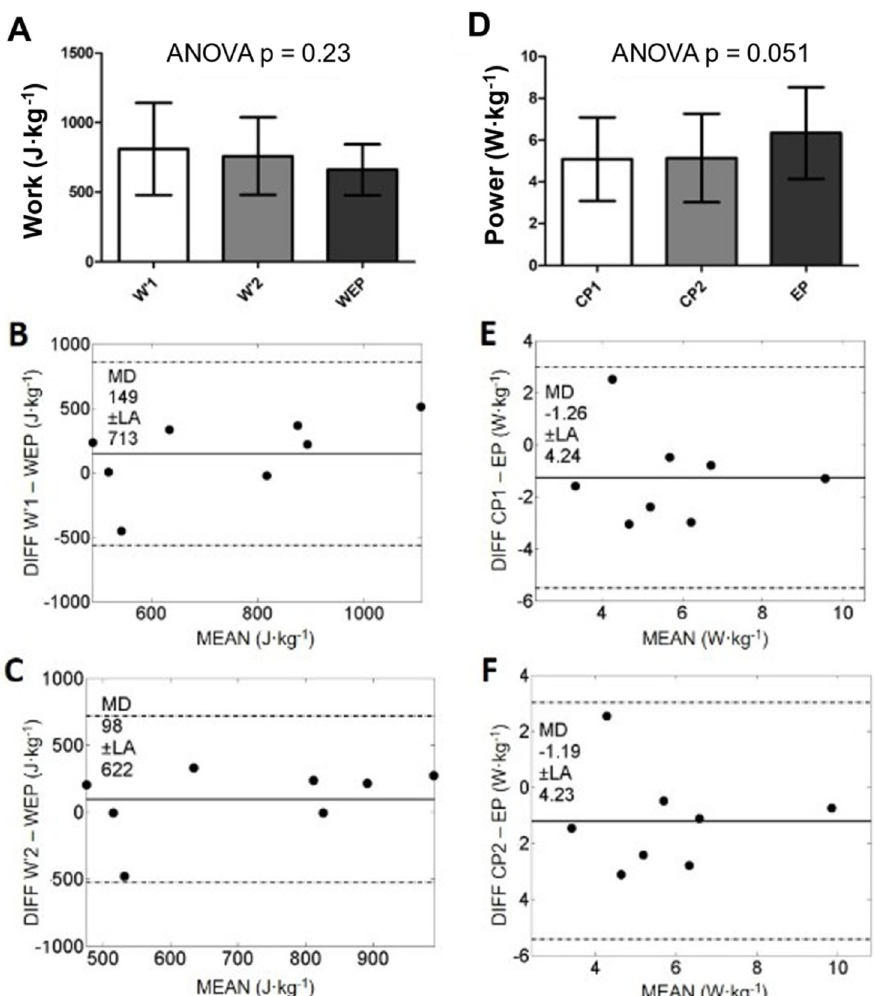
Fig 5. Comparison among WEP and EP derived from AO3 to W 0 and CP from the classical critical power models (A and D), and their respective paired Bland-Altman analysis: W1’ vs. WEP (B), W 0 2 vs. WEP (C); CP1 vs. EP (E), CP2 vs. EP (F). EP–end power; WEP–area above end power; CP1 –Critical power from model 1; CP2 –Critical power from model 2; W 0 1—curvature constant from model 1; W 0 2—curvature constant from model